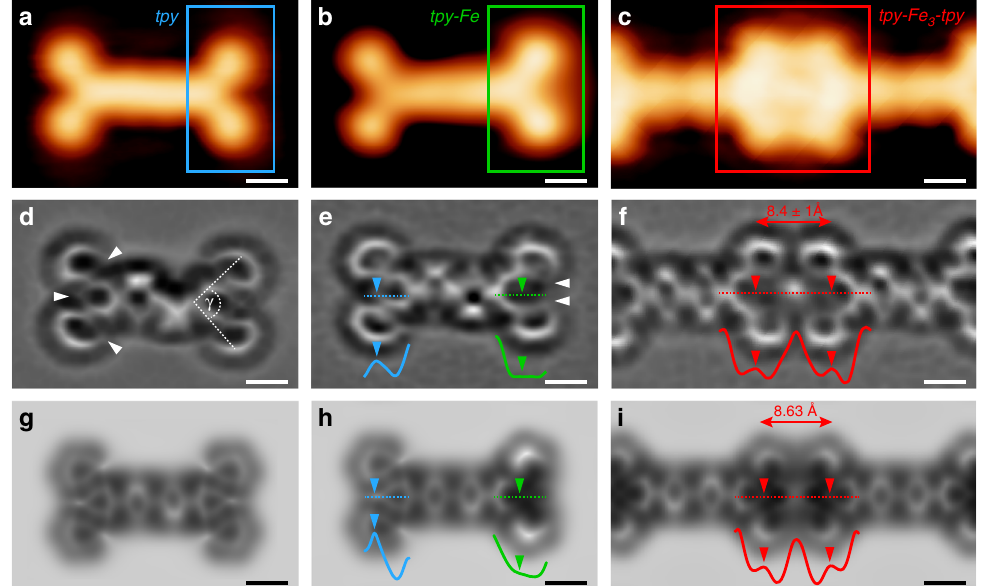
Fig. 2 Intramolecular morphology of the TPPT – Fe coordination motif. An isolated TPPT ( a , d , g ), a singly metalated TPPT ( b , e , h ) and a metal-organic coordination node in a chain ( c , f , i ) are shown. a – c STM images with CO-functionalised tip (( a ): I t = 5 pA, V b = 20 mV; ( b , c ): I t = 10 pA, V b = 20 mV). d – f Constant-height Laplace- fi ltered ncAFM images with CO-functionalised tip [tip height is 0.8 Å above that determined by the STM set point I t = 25 pA, V = 20 mV measured on bare Ag(111)]. g – i Simulated ncAFM images based on DFT calculations (Methods). Coordination node in (i) includes three b linearly arranged Fe atoms. Locations of N atoms correspond to lower intensity areas of pyr [indicated by white arrows in ( d ) and ( e )]. Inset curves: apparent height pro fi les [arb. u.] along the dashed lines. Scale bars: 5